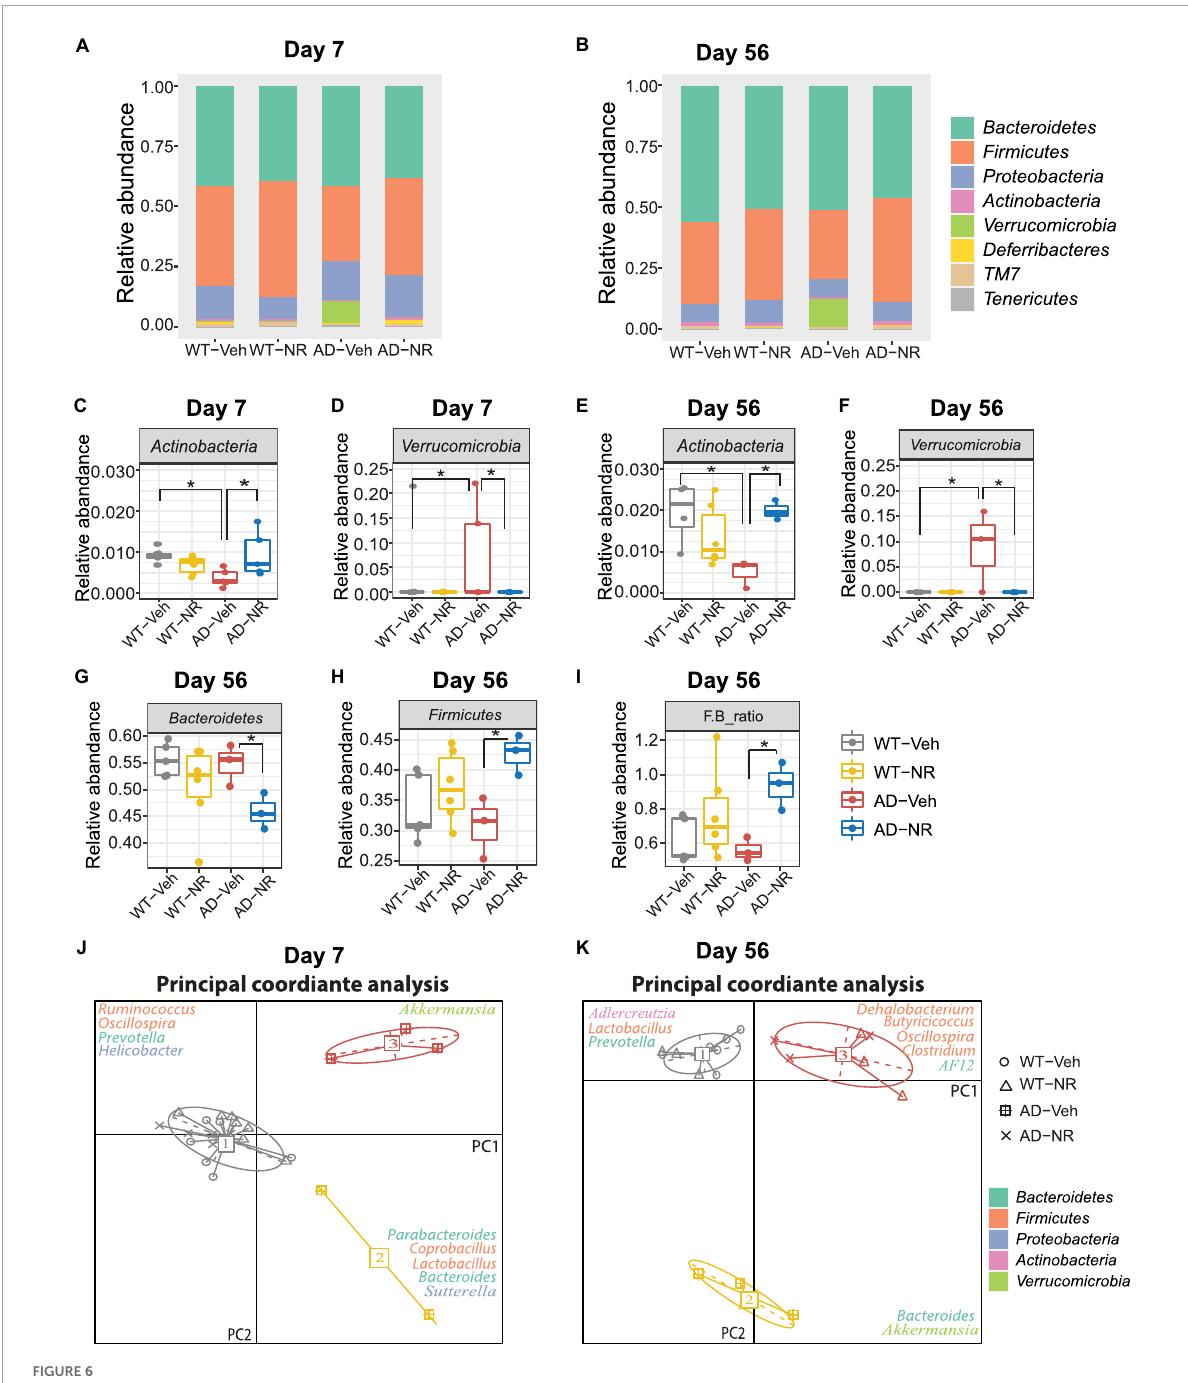
FIGURE6 Microbial communities changed after 1 and 8 weeks of nicotinamide riboside (NR) treatment. (A,B) Microbiome composition at the phylum level on Day 7 (A) and Day 56 (B) . (C–F) The changes in relative abundances of Actinobacteria and Verrucomicriobia on Day 7 (C,D) and Day 56 (E,F) ( n = 3–6). Data showed as mean ± SD. * P < 0.05, two-way analysis of variance (ANOVA) followed by Tukey’s multiple comparisons. (G–I) The changes in relative abundances of Bacteroidetes (G) , Firmicutes (H) , and the F/B ratio (I) on Day 56 ( n = 3–6). Data showed as mean ± SD. * P < 0.05, two-way ANOVA followed by Tukey’s multiple comparisons. (J,K) Enterotype analysis at the genus level of the gut microbiomes on Day 7 (J) and Day 56 (K) , respectively. The data are most naturally separated into three clusters, as determined by the CH index and represented using principal coordinate analysis (PCoA) ( n = 3–6). Data are shown as all samples with a median value. * P < 0.05. For Day 7, WT-Veh (5 males and 1 female), WT-NR (4 males and 2 females), AD-Veh (3 males and 1 female), AD-NR (3 males and 2 female), 10-month-old; For Day 56, WT-Veh (4 males and 1 female), WT-NR (4 males and 2 females), AD-Veh (2 males and 1 female), AD-NR (2 males and 1 female),